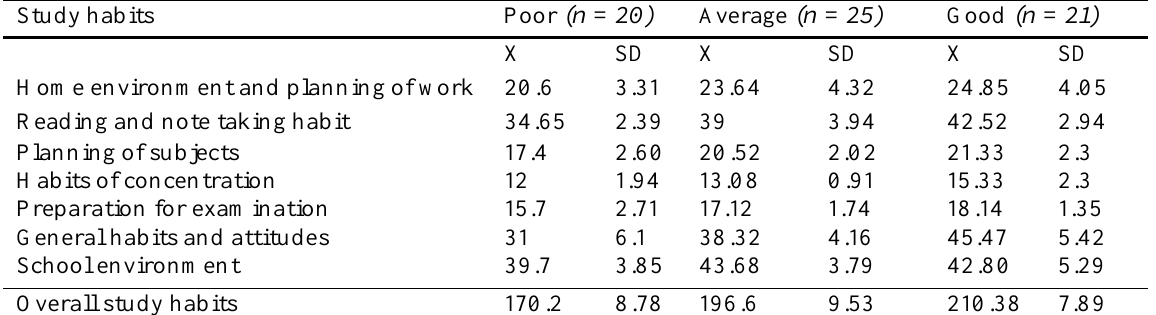
Study Habits Average Scores and Standard Deviations of Sub-Groups Study